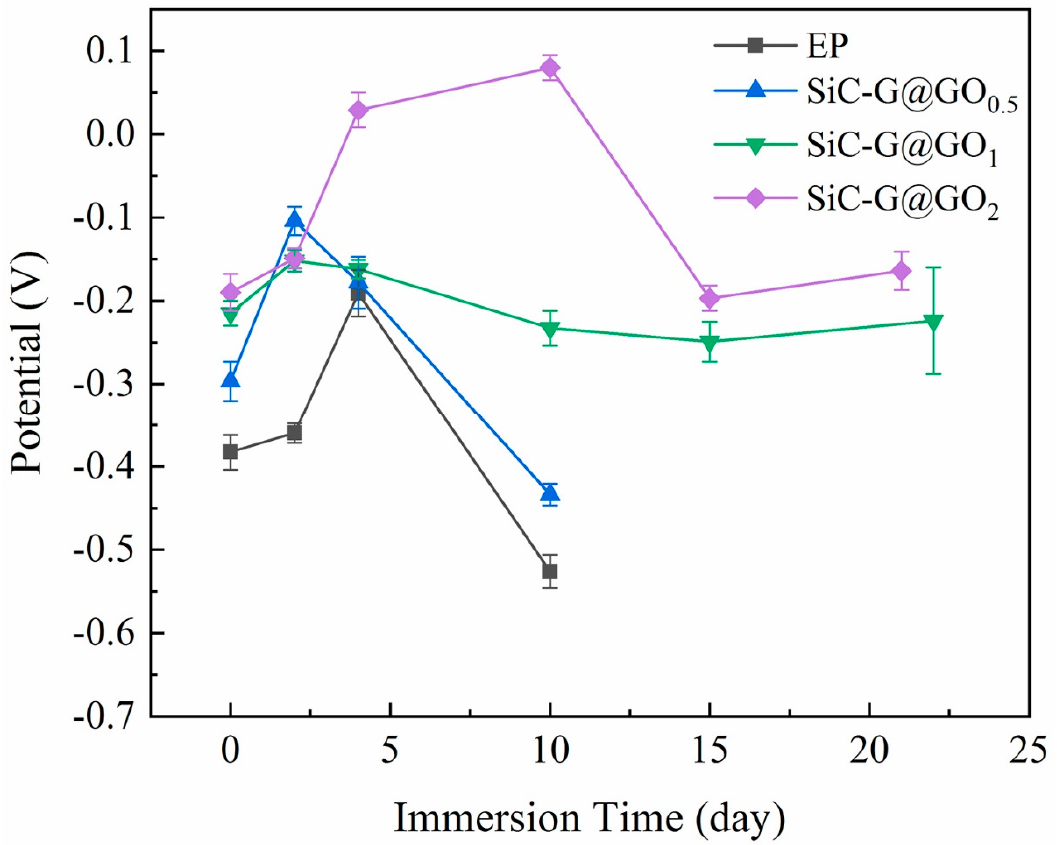
Figure 13. The variation in the OCP values of different coatings as a function of the immersion time (the scatter band reveals the data variation range over the average value of three replicates).